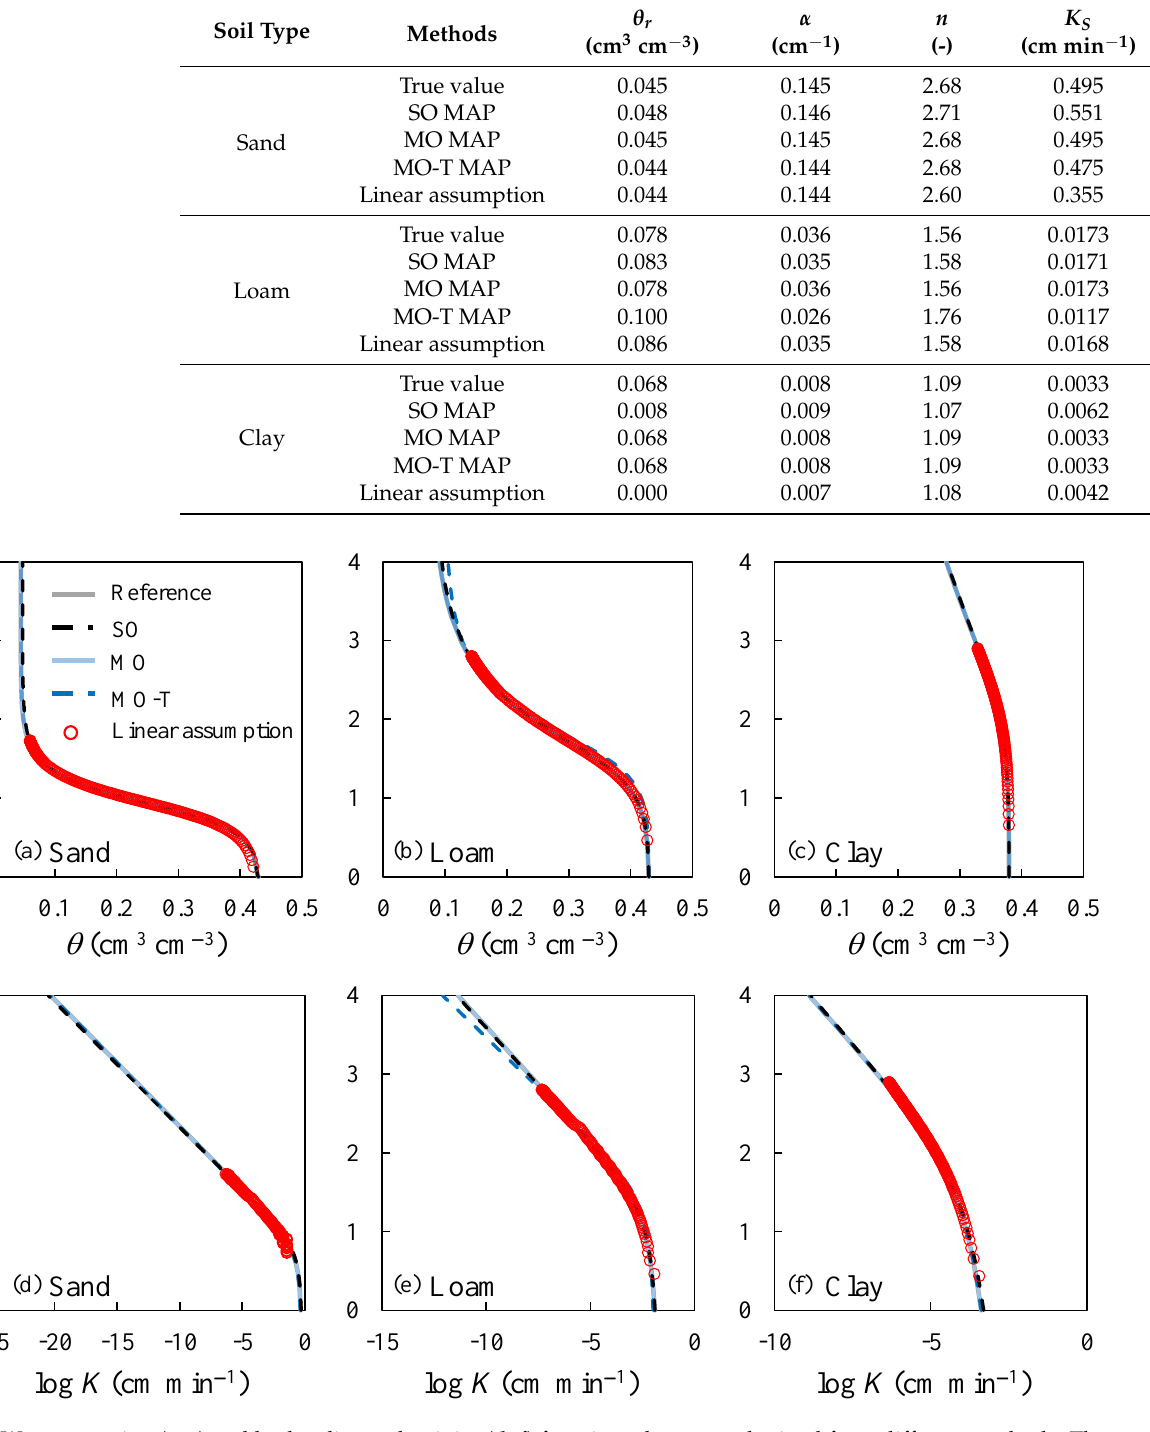
Figure 4. Water retention ( a – c ) and hydraulic conductivity ( d – f ) functions that were obtained from different methods. The SO and MO curves were extracted with the MAP value of the parameters. MO denotes the inversion results of using the exact h a value of − 10 3 cm for the sand and loam examples and − 10 5 cm for the clay example. The results of MO-T were obtained using a different h a value that was ten times the exact